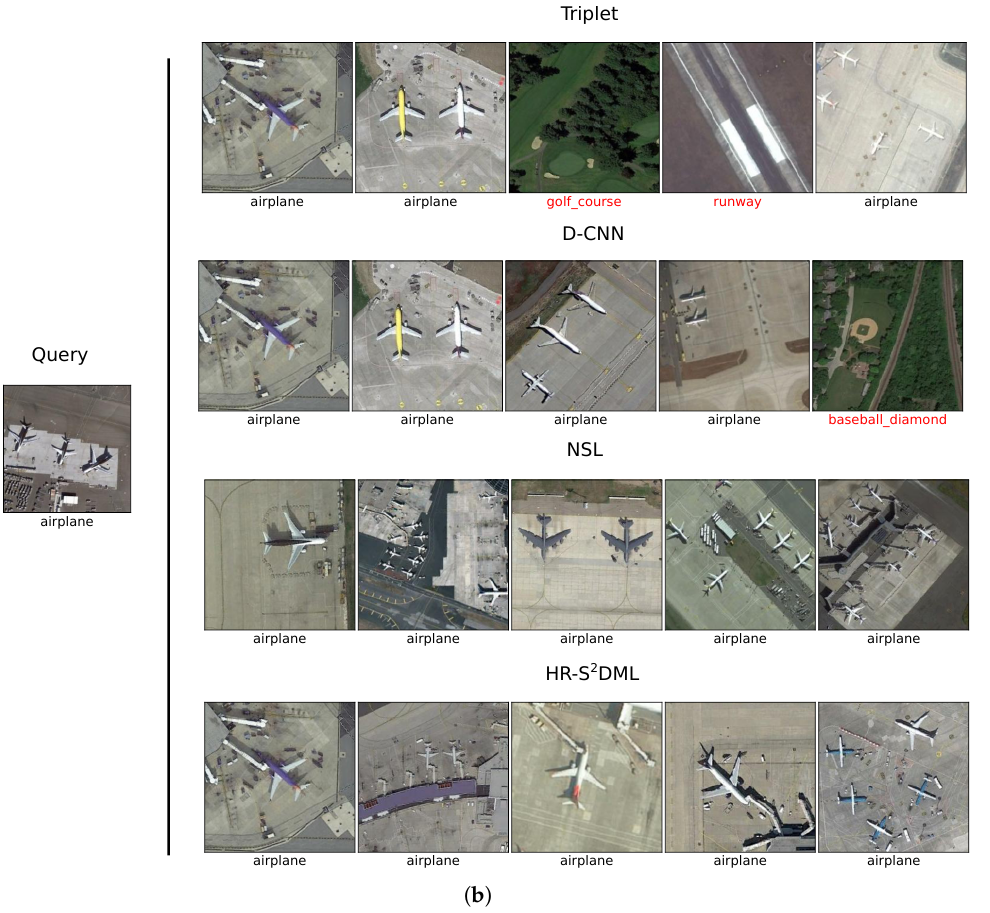
Figure 6. Retrieval examples from the AID ( a ) and NWPU-RESISC45 ( b ) datasets. For each embedding method, the 1st, 5th, 10th, 15th and 20th nearest neighbors are shown.